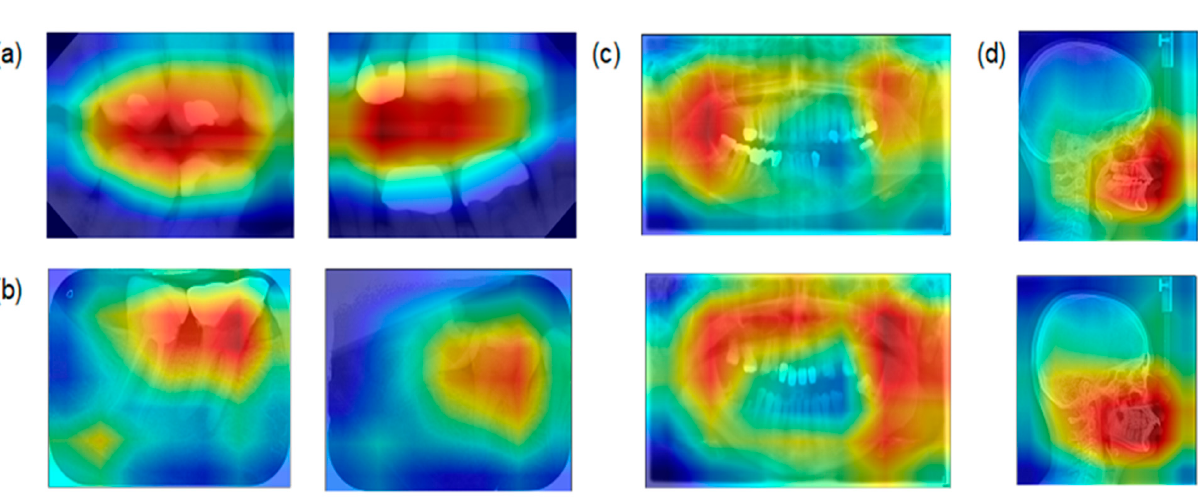
Figure 4. ResNet Gradient-weighted Class Activation Mapping (Grad-CAM) activation maps for ( a ) bitewings, ( b ) periapicals, ( c ) panoramics, and ( d ) cephalometrics. Red areas indicate the most salient regions for the classification, and blue areas the less important regions.